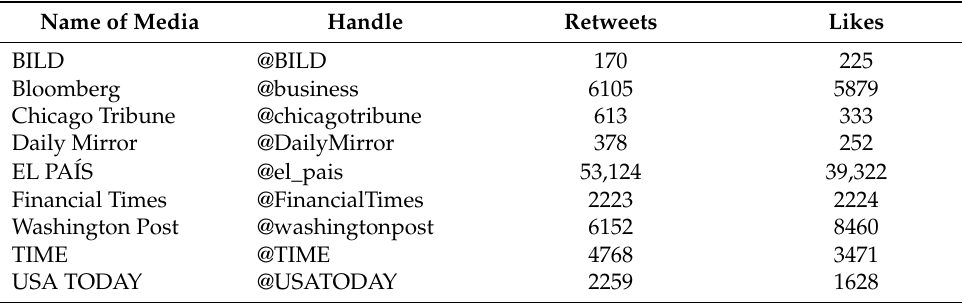
Table 3. Twitter Activity for #Ecuador from 2007–2019